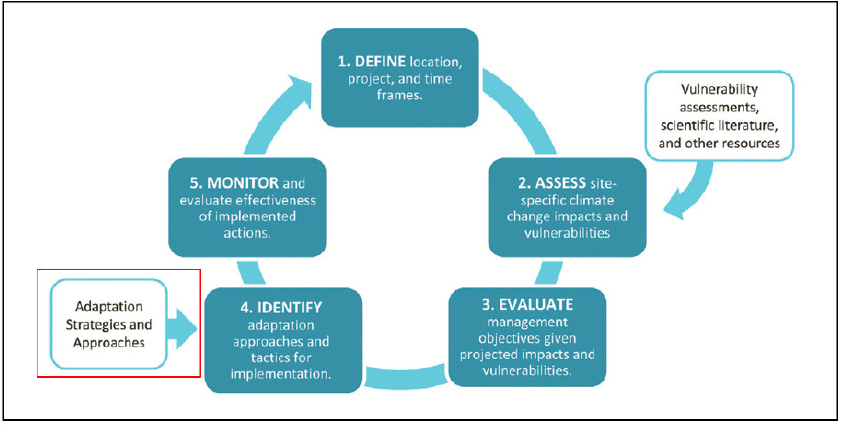
Figure 1. The Climate Change Response Framework Adaptation Workbook process. “Menus” of adaptation strategies and approaches are an input in Step 4. Adapted from Swanston et al. 2016 [46] .